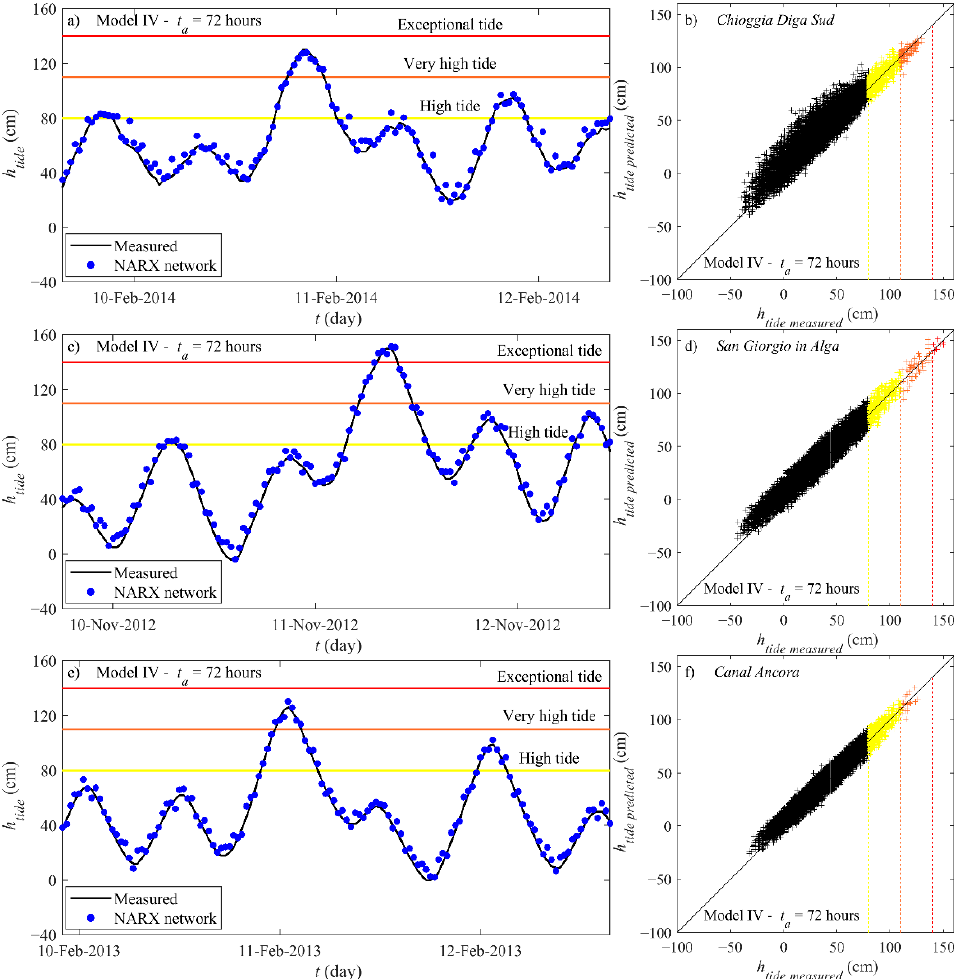
Figure 8. High tide prediction (Model IV— t a = 72 h). On the left : Chioggia Diga Sud—time series in the period between 10 and 12 February 2014 (a) ; San Giorgio in Alga—time series in the period between 10 and 12 November 2012 (c) ; Canal Ancora—time series in the period between 10 and 12 February 2013 (e) . On the right , predicted versus measured values for the validation period for: Chioggia Diga Sud (b) ; San Giorgio in Alga (d) ; Canal Ancora (e) .